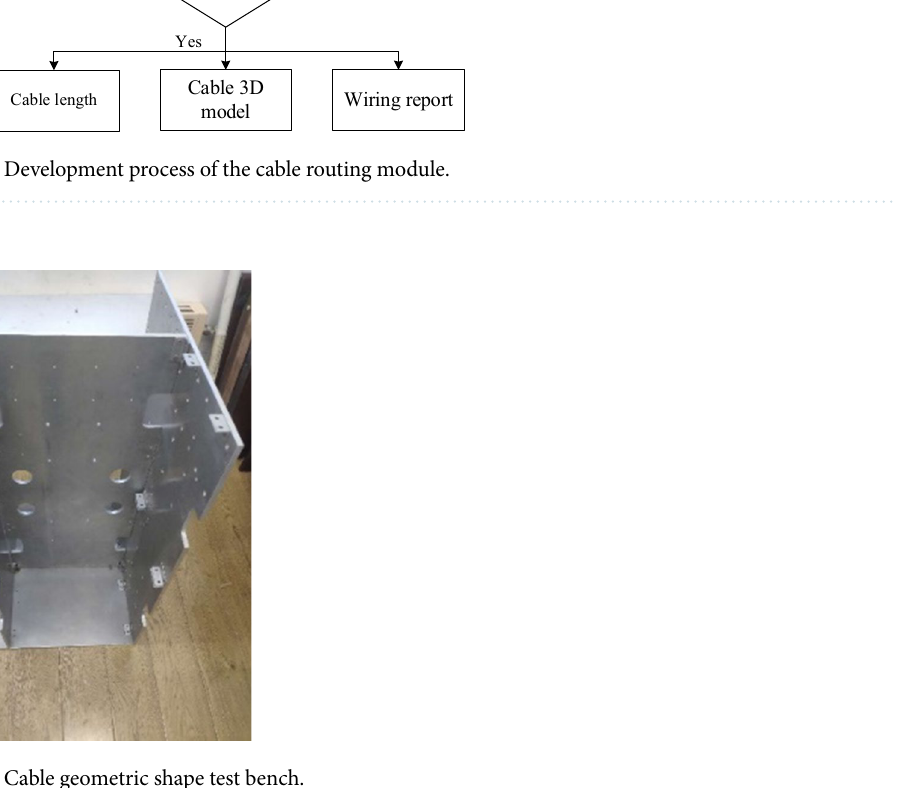
Figure 11. Cable geometric shape test